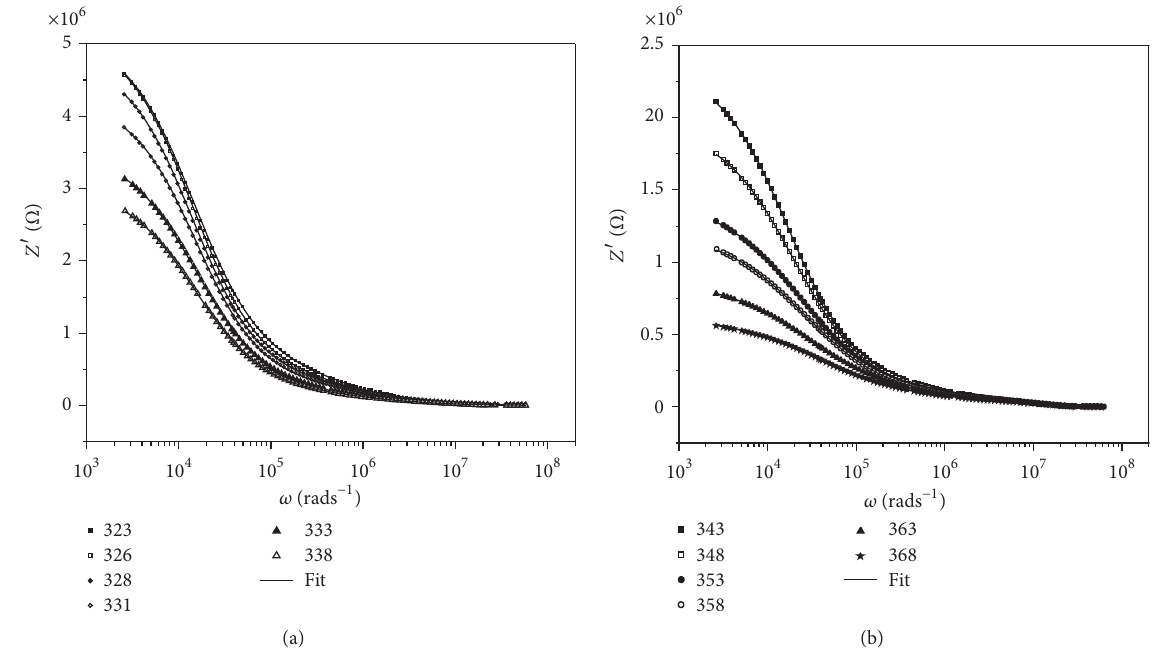
F 7: Frequency dependence of real part of impedance of [(C